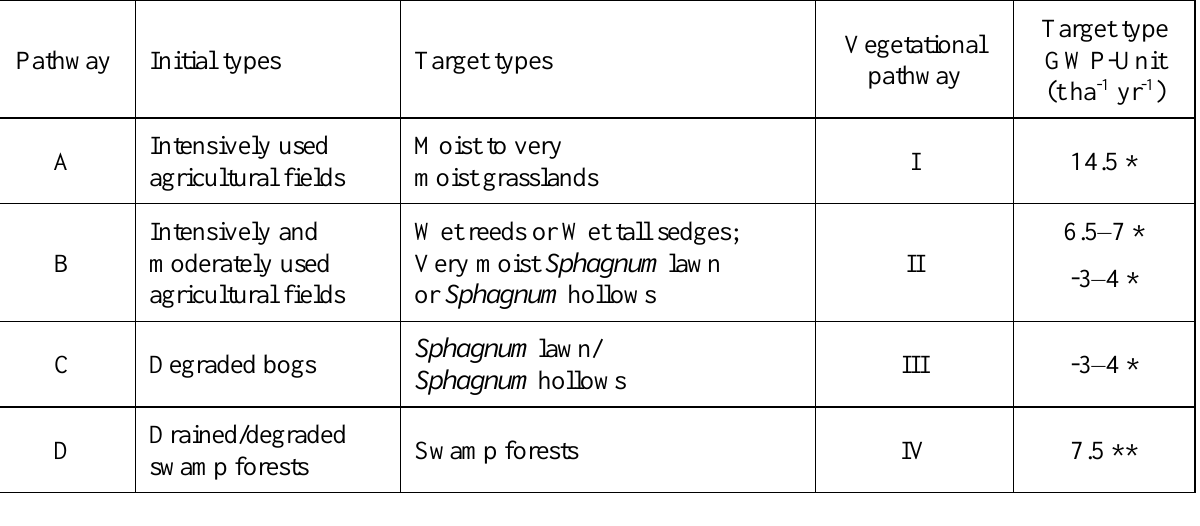
Table 1. Successional pathways of peatlands in Schleswig-Holstein that would be achievable through rewetting and land use change according to several sources; I: Schrautzer et al . 2012; II: Jensen & Schrautzer (1999), Schrautzer et al. (2012); III: González et al. 2013, Lundin et al. 2017; IV: Schrautzer et al. (2021). * GWP (as CO -eq) according to Hirschelmann et al . (2020); ** GWP according to Schrautzer et al . 2